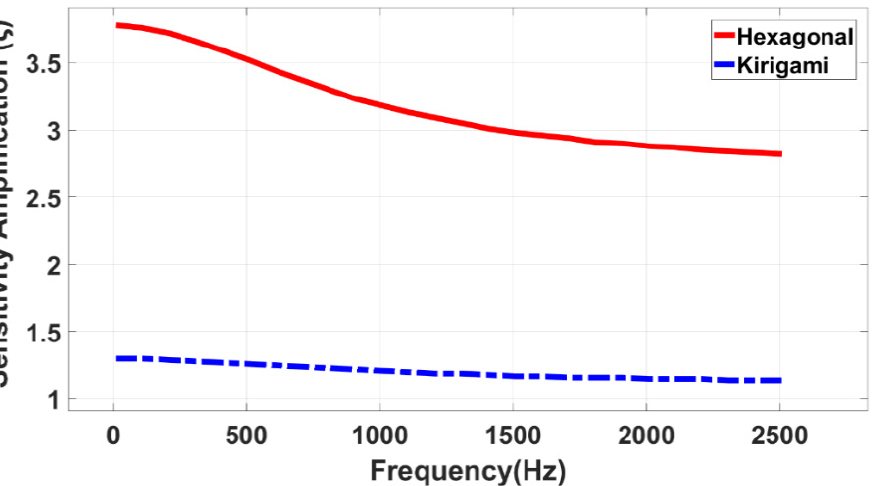
Figure 19. Sensitivity amplification of auxetic hexagonal and kirigami MPSs at different frequen-